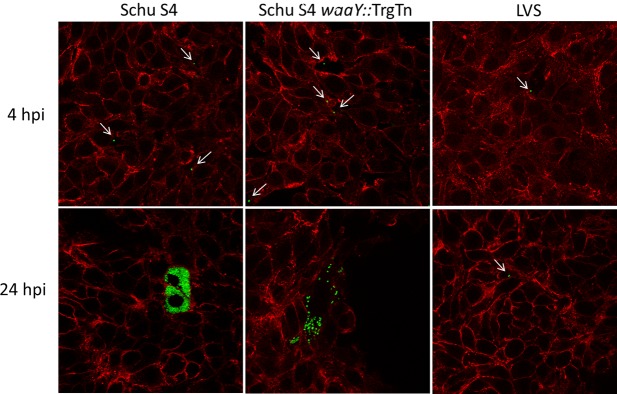
Confocal microscopy of F. tularensis Schu S4, F. tularensis waaY::TrgTn and F. tularensis LVS growth in cultured human alveolar type II cells.Immortalized primary AT-II cells were infected at an MOI of 100:1 and confocal microscopy was performed with cells stained for actin (red). In addition, each Francisella strain contained a plasmid encoding GFP and is represented as green. The thin white arrows point to single Francisella within cells.